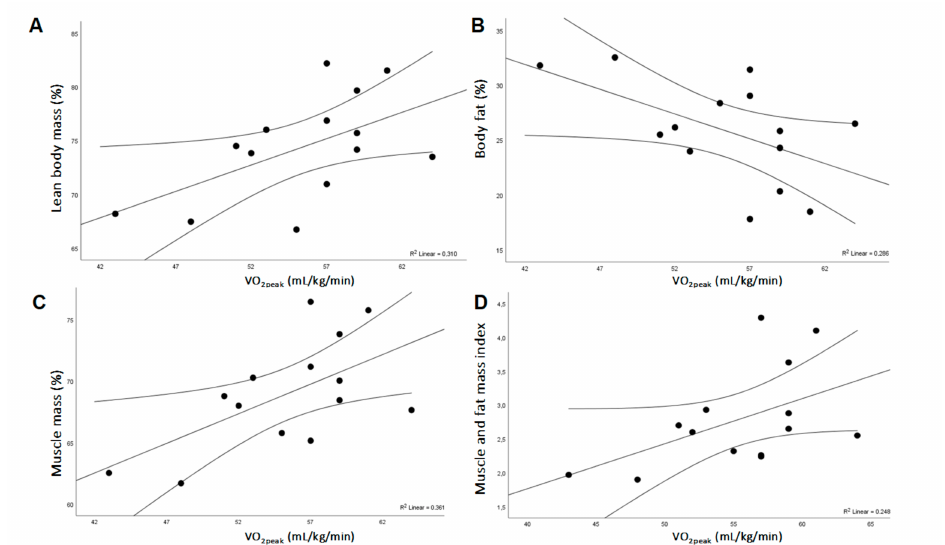
Figure 1. Relationship between the cardiorespiratory fitness and the body